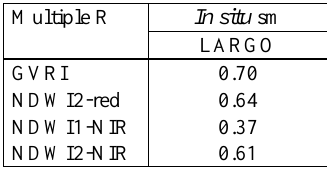
Table 2. Statistical results of the linking model for the two LARGO datasets and the chosen indices. *not significant